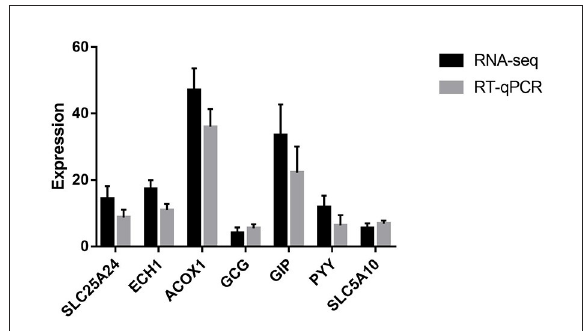
FIGURE2 RT-qPCR validation of the selected seven genes. SLC25A24 solute carrier family 25 member 24; ECH1 , enoyl-CoA hydratase 1; ACOX1 , acyl-CoA oxidase 1; GCG , glucagon; GIP , gastric inhibitory polypeptide; PYY , peptide YY; SLC5A10 , solute carrier family 5 member